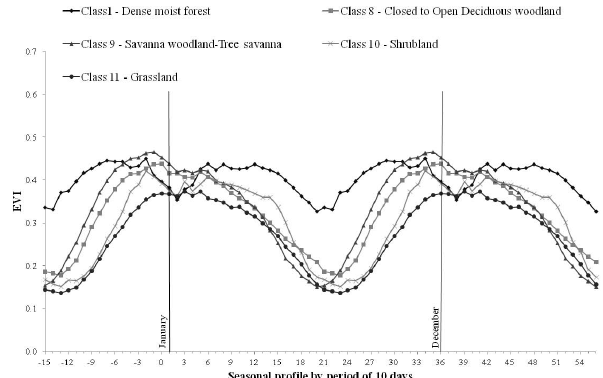
Fig. 7. EVI Seasonal profile by period of 10 days (January to De- cember between the vertical lines) for classes (1, 8, 9, 10 11) situ- ated in the southern